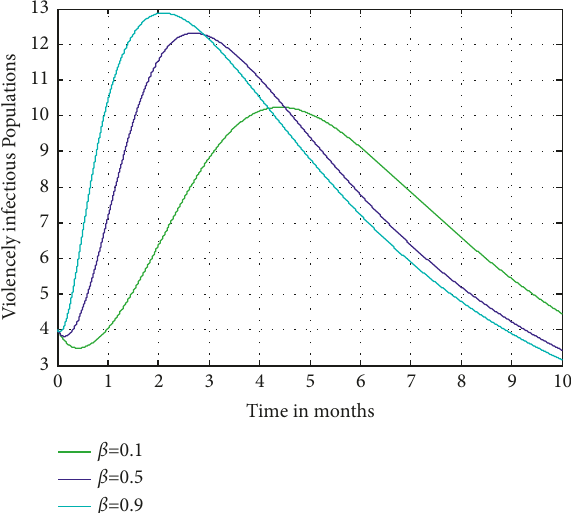
Figure 3: Effect of the diffusion rate β on the violently infectious 0 individuals. P. <